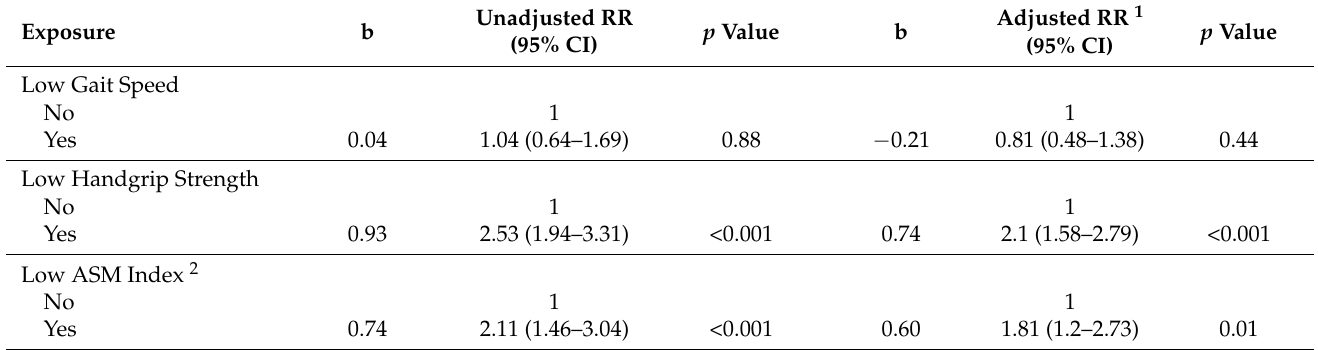
Table 4. GEE analysis showing longitudinal effect of sarcopenia components with cognitive